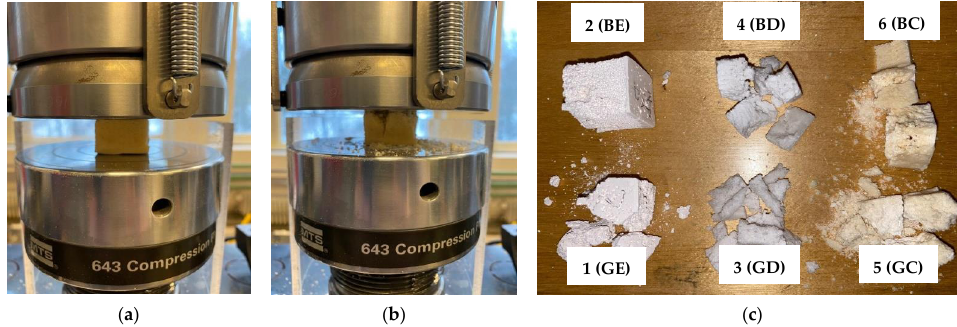
Figure 9. Mechanical testing on the compression force of the developed scaffold samples: ( a ) sample under testing at the ( a ) initial and ( b ) final stage; ( c ) example of a sample from each group that was subjected to compressive testing.